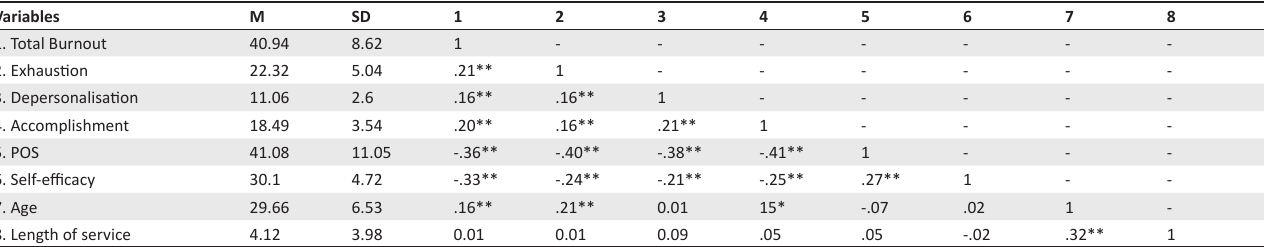
TABLE 2: Correlation matrix ( r ) of the latent variables ( n = 268). Variables